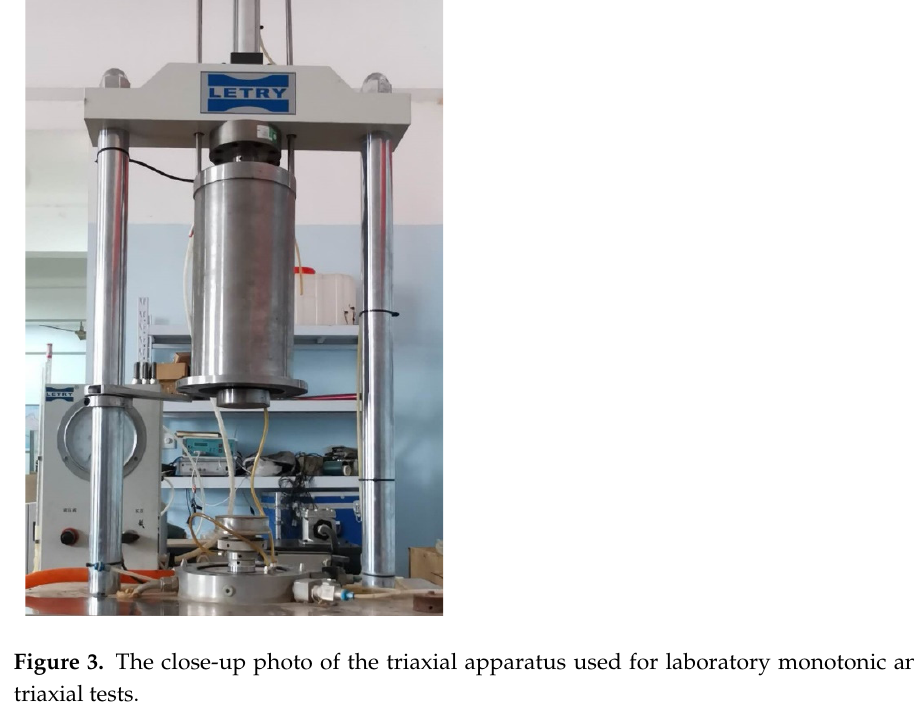
Table 2. The testing matrix of laboratory repeated load triaxial tests.